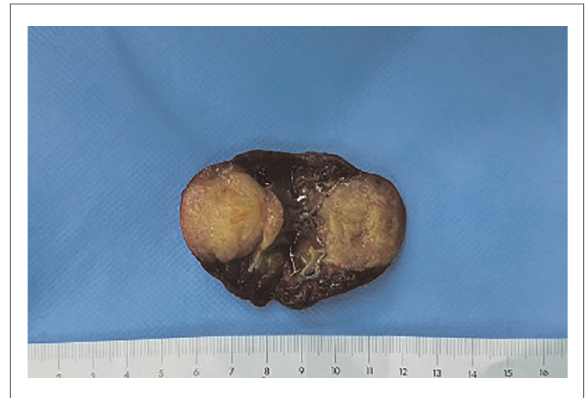
FIGURE 4 Right kidney was resected radically with a solid mass in the middle, yellow and white